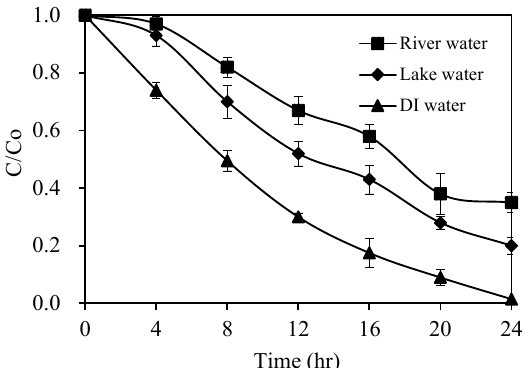
Figure 15. ( a ) Cycling runs and ( b ) XRD patterns of 1.0 wt% Pt/AgInS 2 photocatalyst before and after the experiments.